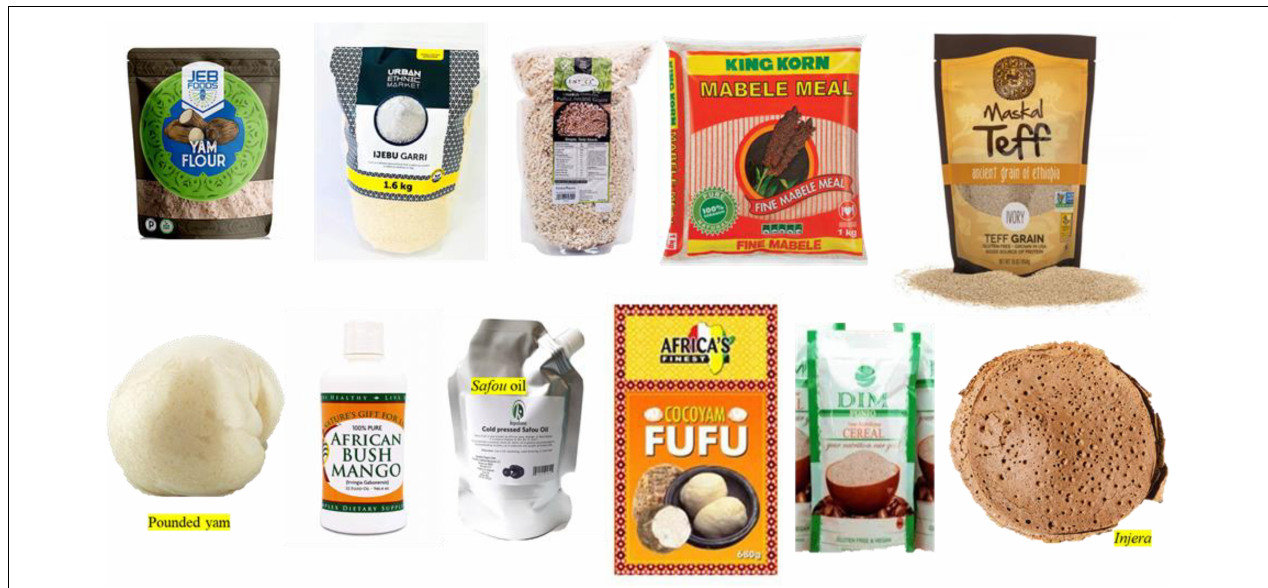
FIGURE 4 | Some African processed foods (https://www.google.com/search?q=african+processed+foods&rlz=1C1CHBF_enZA990ZA990&sxsrf=APq-WBtQ l6wnr_h-2NX_pG9IAOcEX6L9_g:1647524662762&source=lnms&tbm=isch&sa=X&ved=2ahUKEwj09qDSo832AhUBgFwKHeIeCDEQ_AUoAXoECAEQAw&biw=